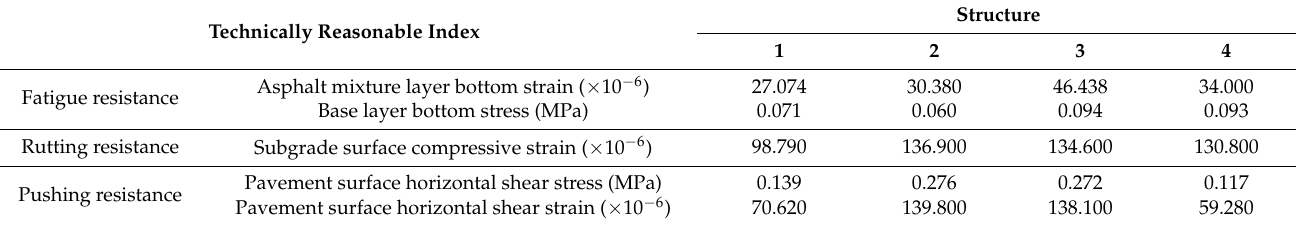
Table 12. Calculation results using FE pavement performance indicators.